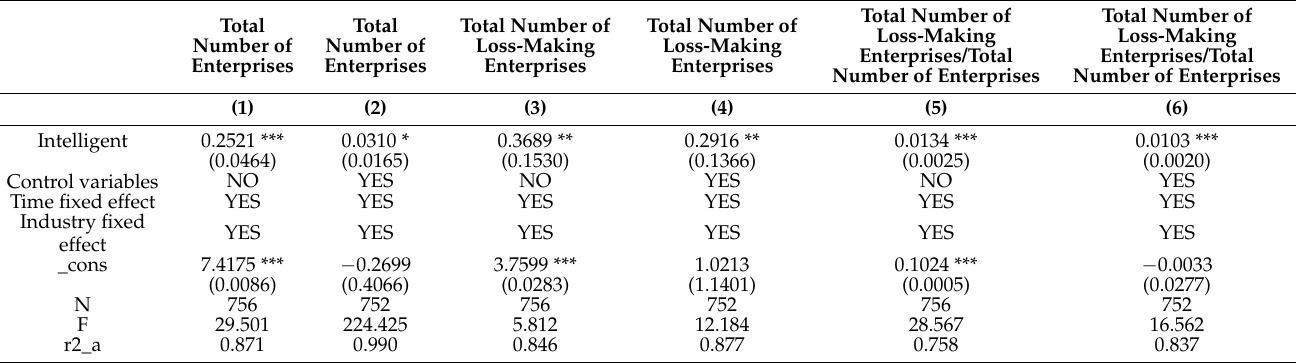
Table 11. The impact of intelligent manufacturing on enterprise